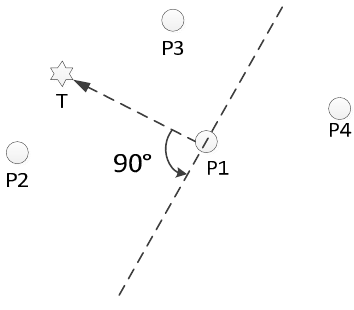
Figure 5. AODV-DTN flooding using geographic location information.